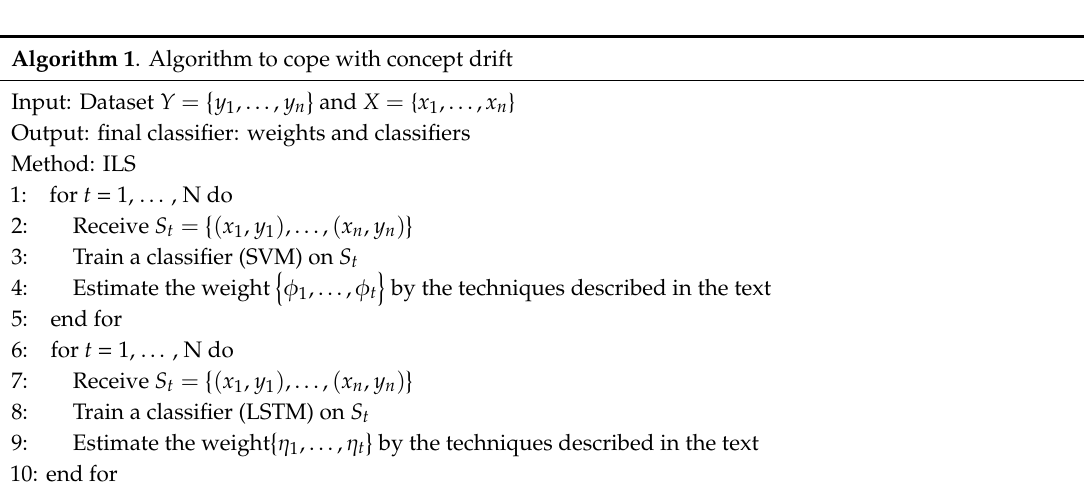
Algorithm 1 . Algorithm to cope with concept drift